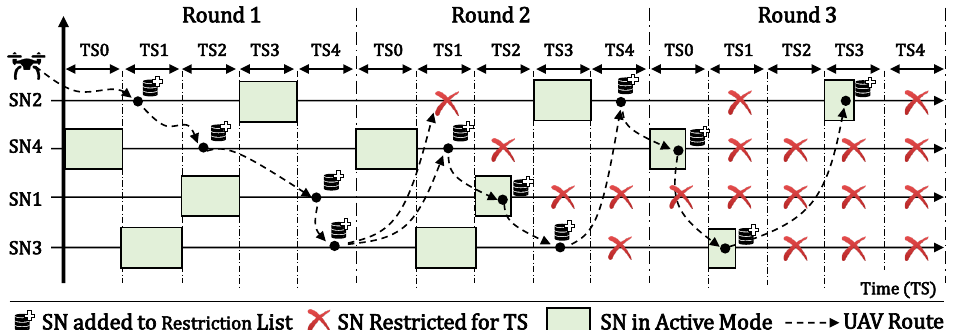
Figure 10. Graphical representation of the UAV search